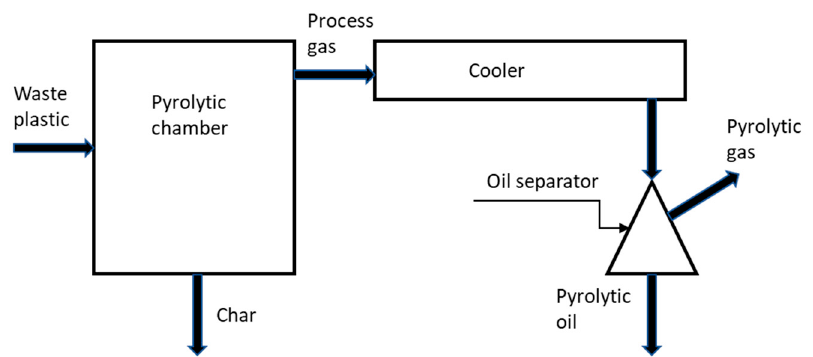
Figure 1. Scheme of the test stand for carrying out the pyrolysis process.